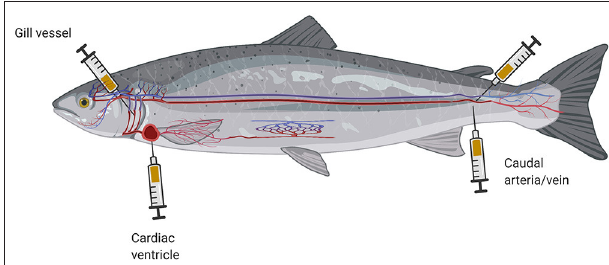
FIGURE 2 | Schematic illustration of different cannula placements for blood collection from fish (created with BioRender.com).